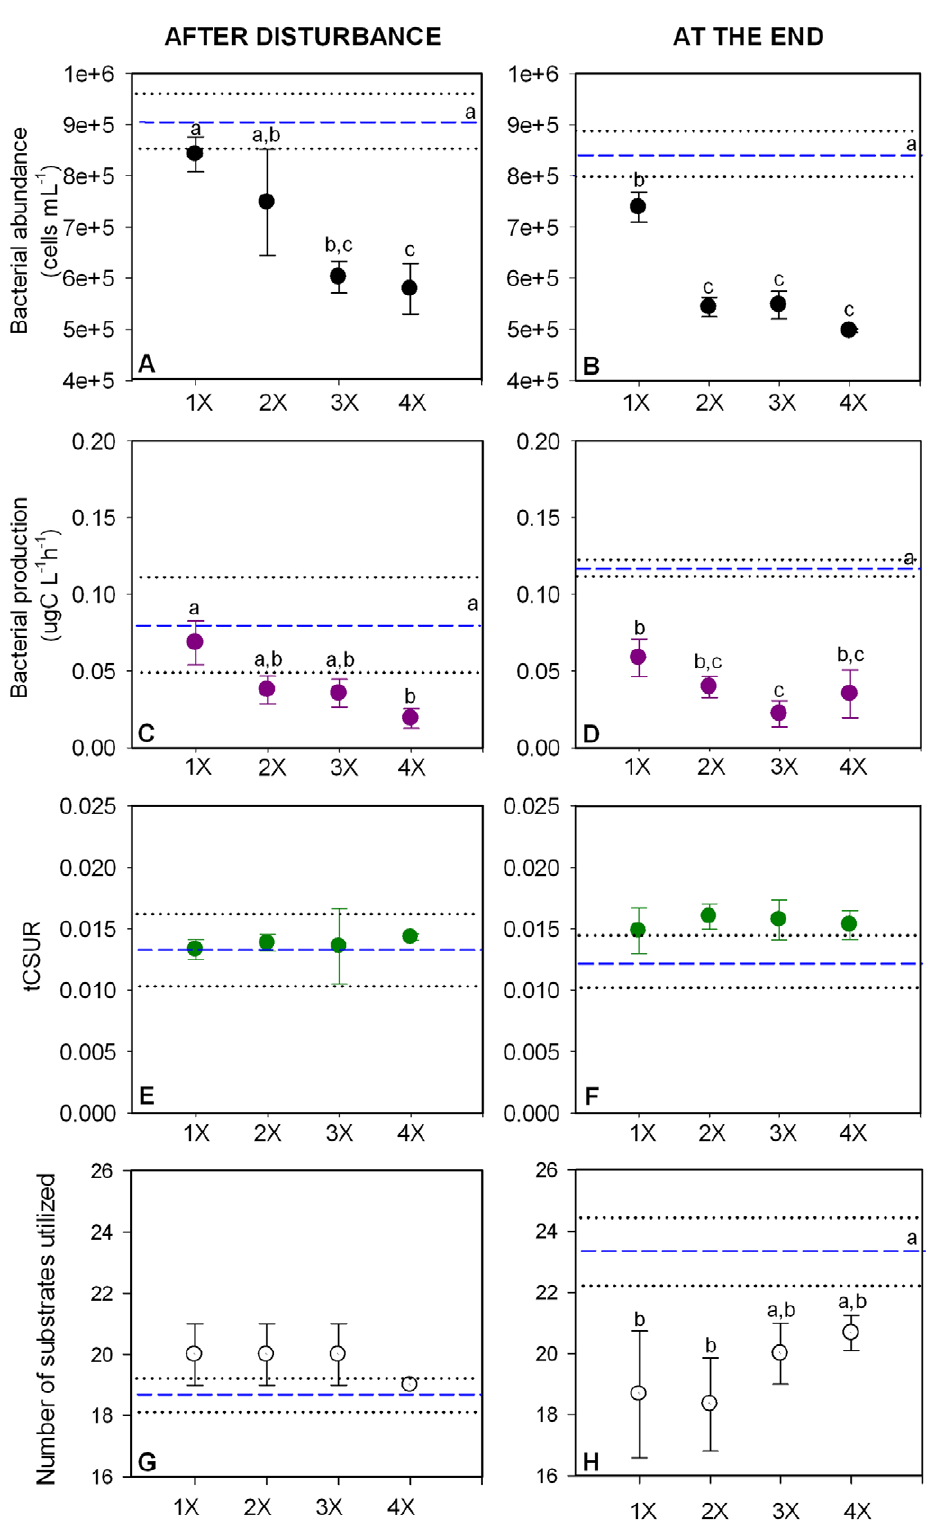
Figure 4. Functional changes in the disturbance frequency experiment (Experiment 2). Values presented correspond to mean values 6 standard deviation of bacterial abundance (A, B), bacterial production (C, D), total carbon substrate utilization rate (tCSUR; E, F) and number of substrates with a positive response (G, H) for the different treatments. Mean values of controls are represented as dashed lines (- -), while standard deviation from control are represented as dotted lines ( ??? ). Tukey’s homogenous groups are represented by a, b and c.